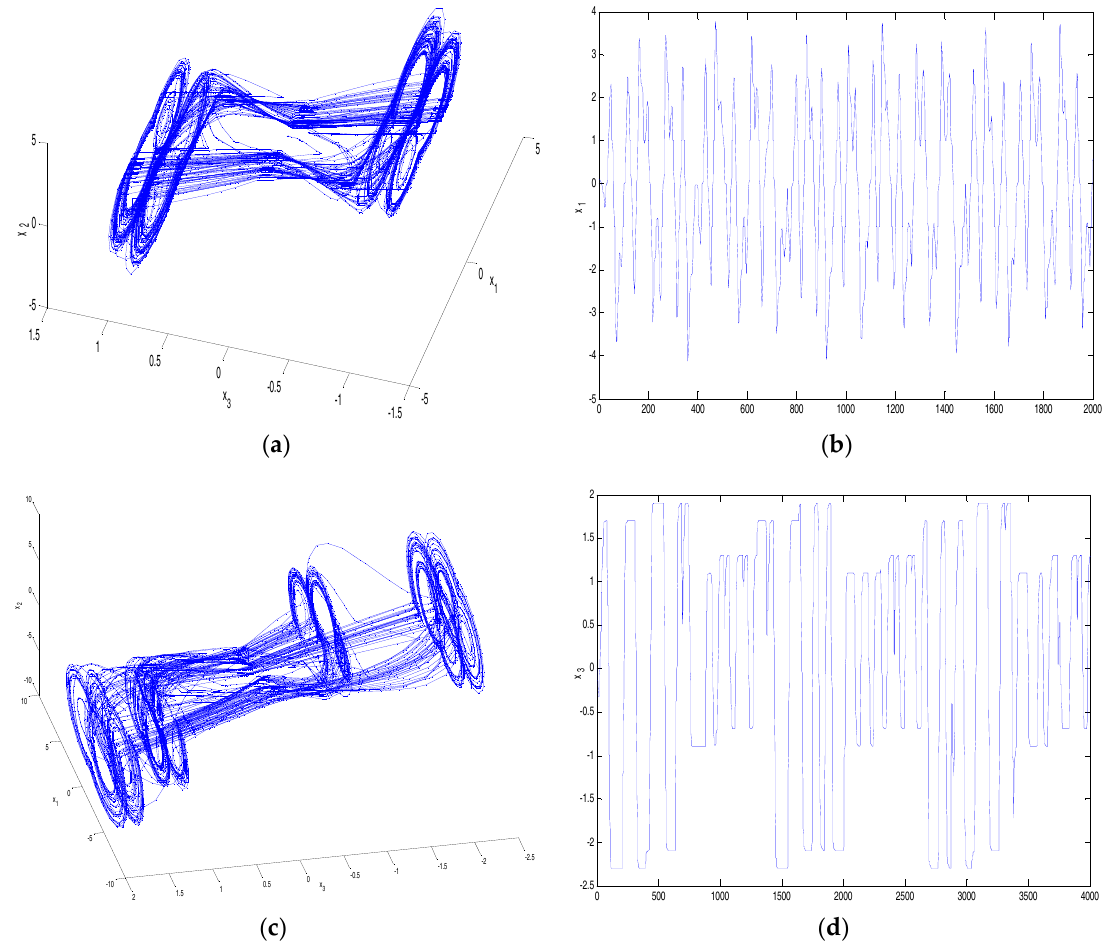
Figure 12. Numerical results of the 3 ‐ D multi ‐ scroll attractors ‐ III: ( a ) 2 ‐ double scrollin x 1 ‐ x 2 ‐ x 3 plane; ( b ) variable x 1 (t); ( c ) 8 ‐ double scrollin x 1 ‐ x 2 ‐ x 3 plane; and ( d ) variable x 3 (t).